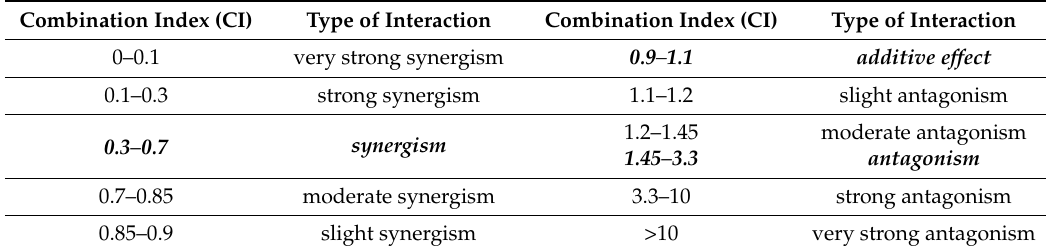
Table 1. Summary of interaction types related to combination index (CI) values